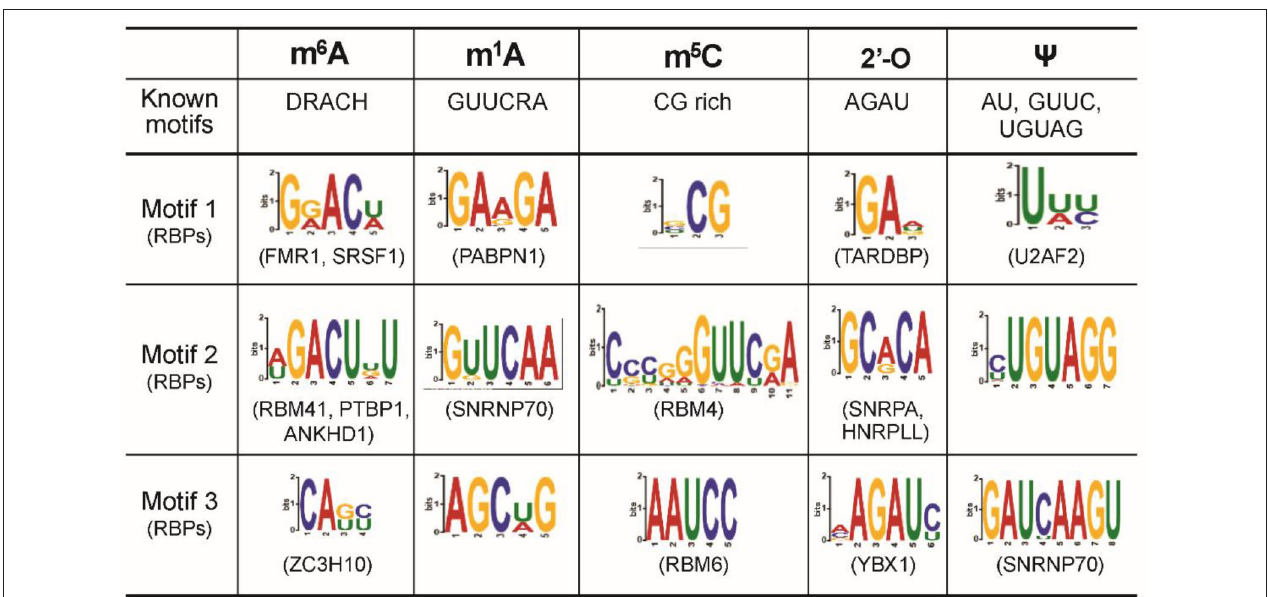
FIGURE 6 | The top motifs of different transcriptome modifications learned by